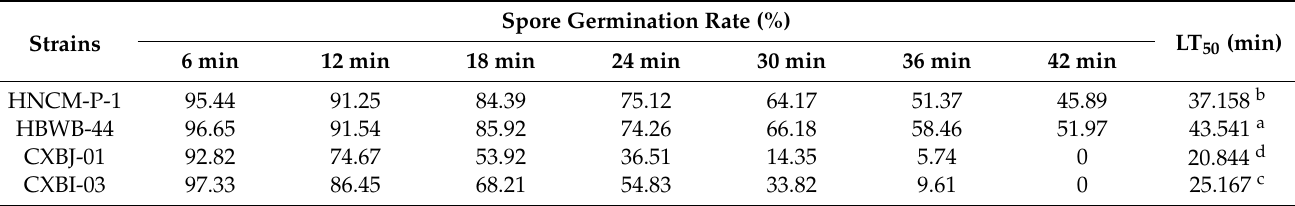
Table 6. Spore germination rate of different strains under 48 ◦ C heat stress.